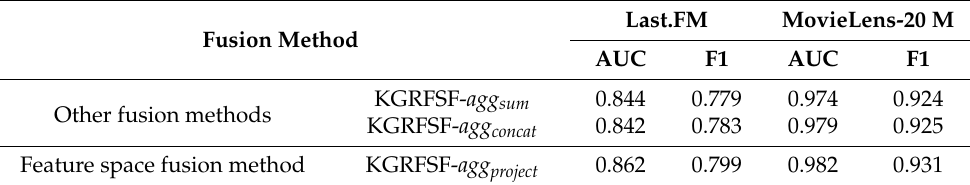
Table 4. Influence of the fusion method on recommendation